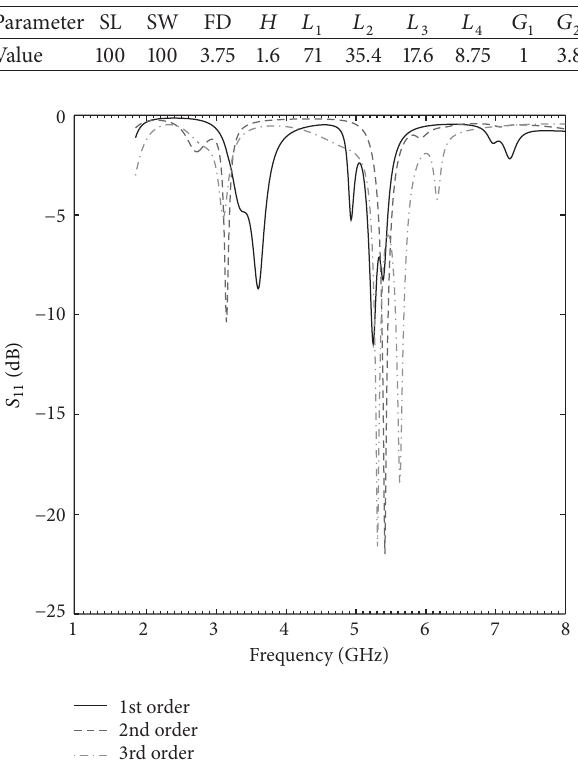
Table 1: Detailed dimensions of the proposed antenna (unit: mm).